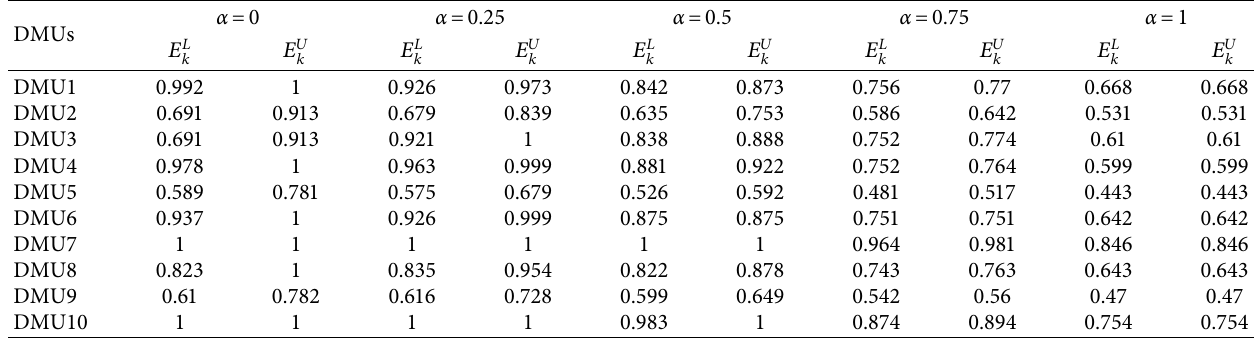
Table 3: The total efficiency of DMUs at different α -cut levels.